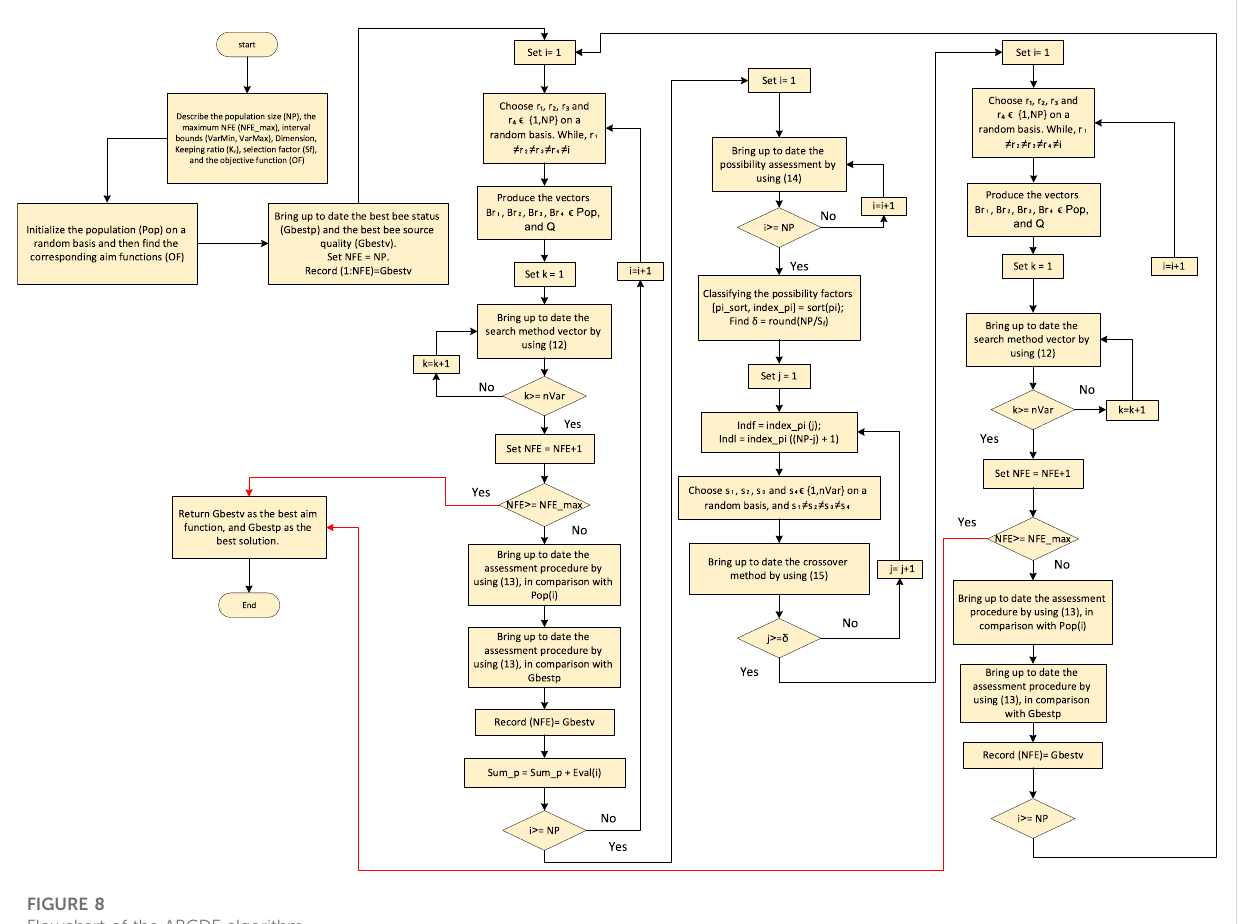
FIGURE 8 Flowchart of the ABCDE algorithm.